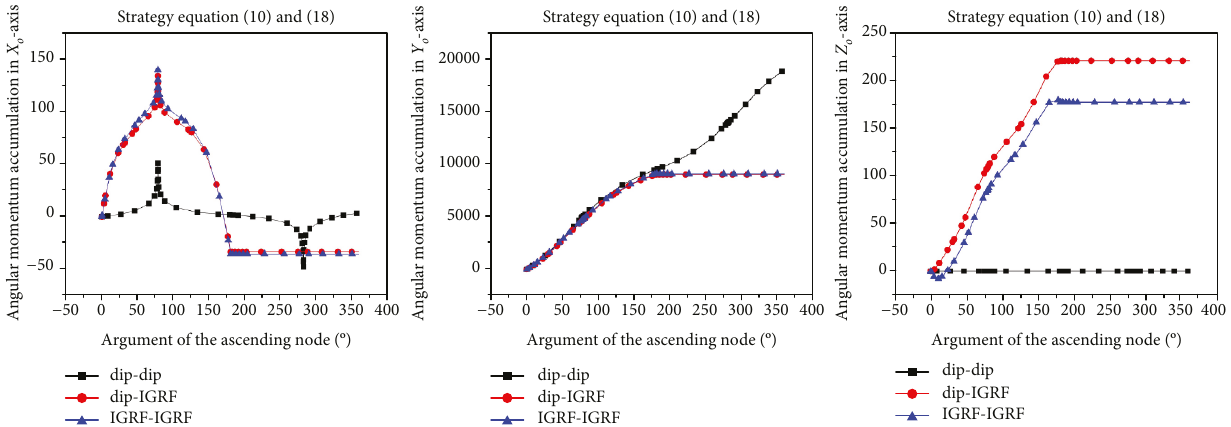
Figure 13: Main angular momentum accumulation (orbital coordinates) in the elliptical orbit with an inclination of 90 ° (400km to 1950km) under equation (10) (Example 8).